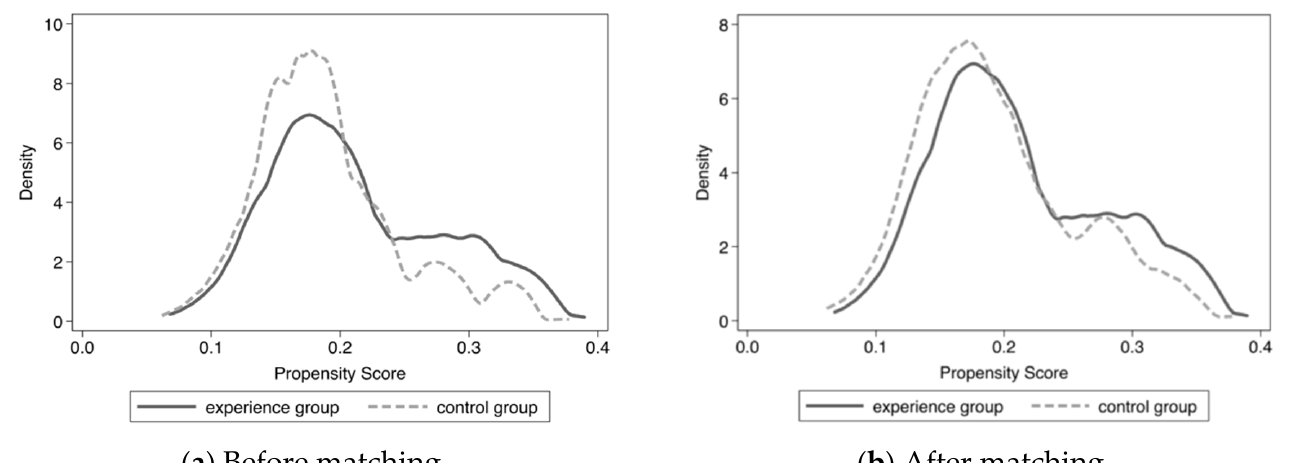
Figure 2. Comparison of kernel density function before and after matching. Table 5. Results of the balance test.